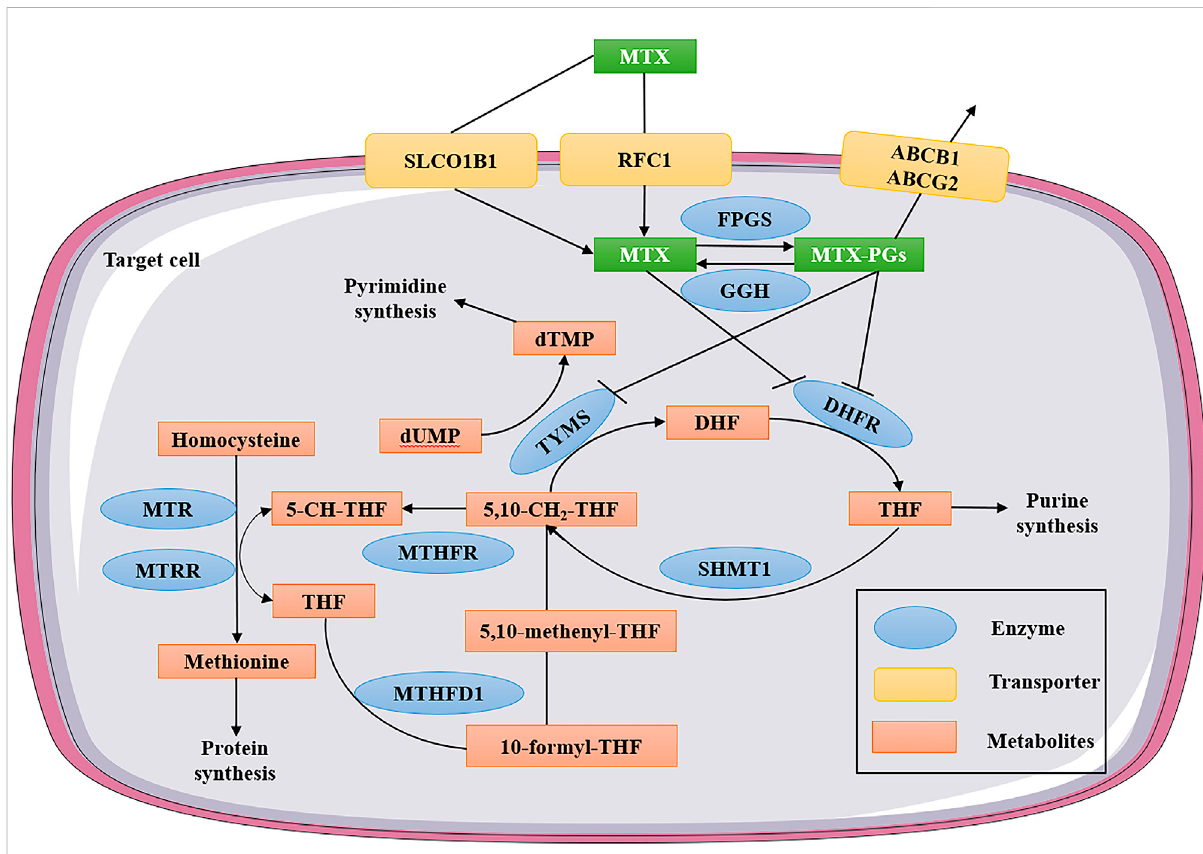
FIGURE 1 MTX intracellular folate metabolic pathway. MTX enters the cell through active transport mediated by RFC1 or SLCO1B1. After entering the cell, MTX is transformed into MTX-PGs under the action of FPGS. MTX-PGs is the sequential addition of multiple glutamate residues to the γ -carboxyl groupoffolateandMTXtoensureeffectiveintracellularretention.Atthesametime,GGHconvertsMTX-PGsbacktoMTX.Subsequently,glutamate- free MTX was exported from the cell with the participation of members of the ATP-binding box superfamily (ABCB1 and ABCG2). The main targets of MTX and MTX-PGs are DHFR, TYMS and several other enzymes involved in purine synthesis. MTX — methotrexate; MTX-PGs — MTX polyglutamates; RFC1 — reduced folate carrier 1; SLCO1B1-solute carrier organic anion transporter family member 1B1; ABCB1 — ATP-binding cassette subfamily B member 1; ABCG2 — ATP-binding cassette subfamily G member 2; FPGS — folylpolyglutamate synthetase; GGH — gamma- glutamyl hydrolase; DHFR — dihydrofolate reductase; TYMS — thymidylate synthetase; MTHFR — methylenetetrahydrofolate reductase; MTHFD1 — methylenetetrahydrofolate dehydrogenase; MTR — methylenetetrahydrofolate-homocysteine methyltransferase; MTRR — 5- methylenetetrahydrofolate-homocysteine methyltransferase reductase; SHMT1 — serine hydroxymethyltransferase 1; THF — tetrahydrofolate; DHF — dihydrofolate; dUMP — deoxyuridine monophosphate; and dTMP — deoxythymidine